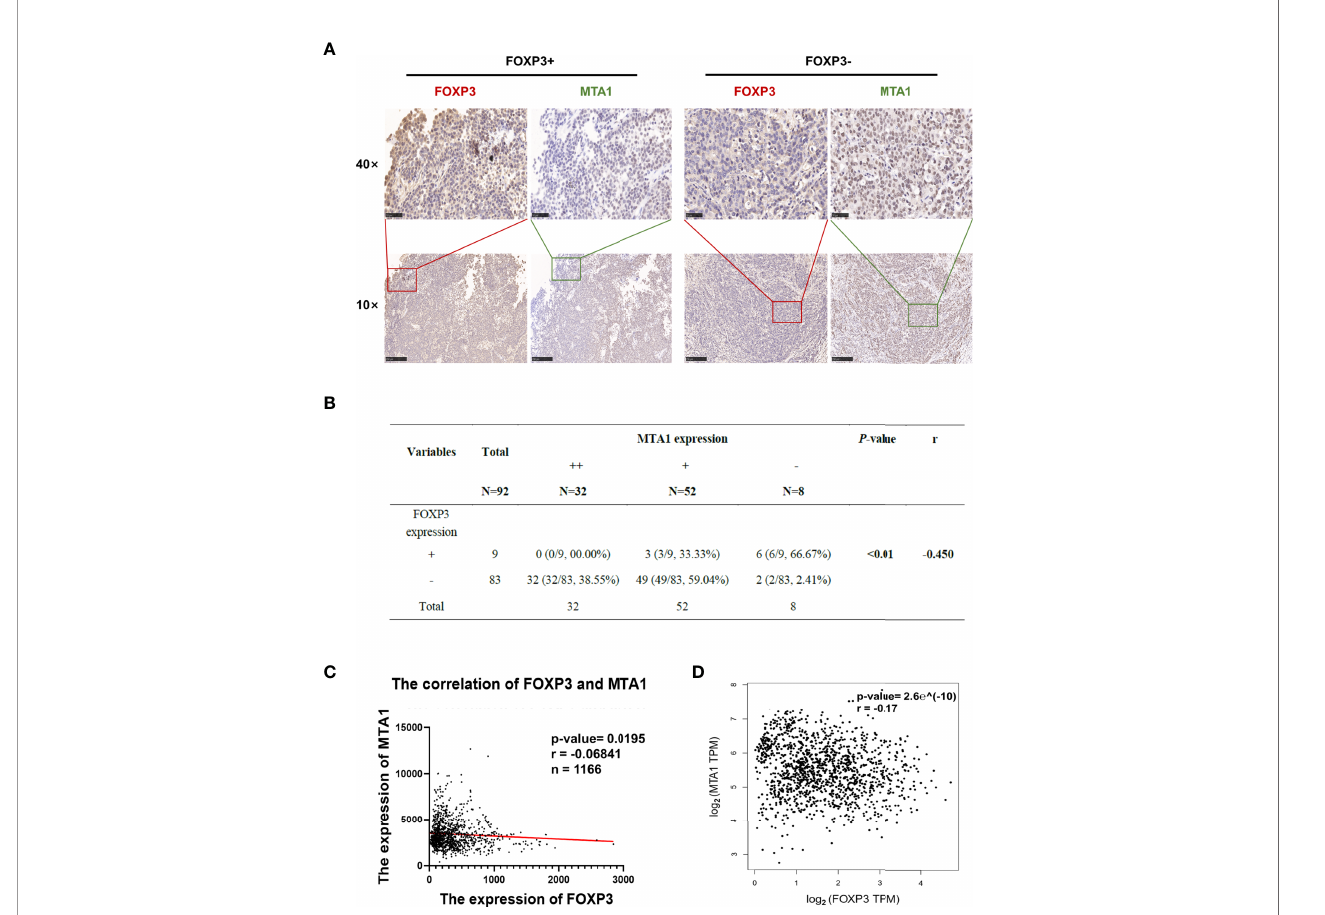
FIGURE 4 | FOXP3 expression and MTA1 expression were negatively correlated in clinical breast cancer samples. (A) The expression level of MTA1 was lower in breast cancer tissues with positive FOXP3 expression than in breast cancer tissues with negative FOXP3 expression. FOXP3 expression was negatively correlated with MTA1 expression. Scale bars, 250 m m (10×) and 50 m m (40×). (B) A negative correlation between nuclear FOXP3 expression and MTA1 expression was found in breast cancer specimens. Spearman rank correlation analysis. (C) Analysis of 1166 breast cancer patients in the TCGA database showed a negative correlation between FOXP3 and MTA1 expression levels in clinical breast cancer samples. Pearson correlation analysis. (D) Data from breast cancer cases were analysed on the GEPIA website, verifying that the expression levels of FOXP3 and MTA1 were negatively correlated in clinical breast cancer samples. Pearson correlation